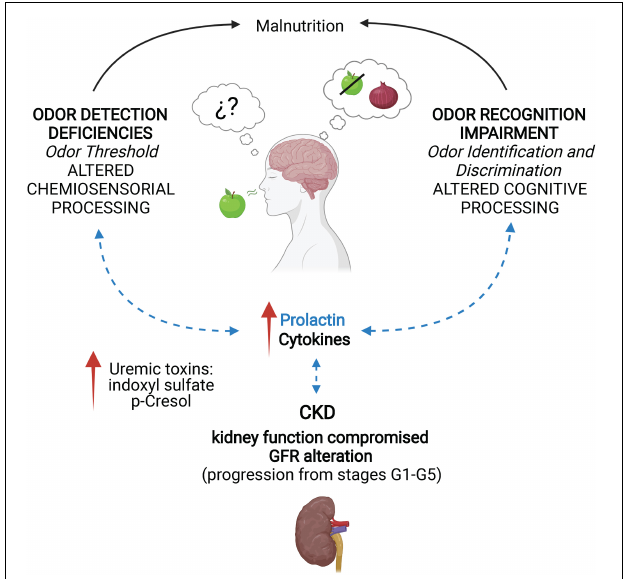
FIGURE 1 | Neuroimmune alterations and olfactory deficiencies promoted by chronic kidney disease. In chronic kidney disease (CKD), kidney function is compromised due to alterations of the glomerular filtration rate (GFR), as the disease progresses from stage G1 ( ≥ 90 ml/min/1.73 m 2 ) to G5 ( < 15 ml/min/1.73 m 2 ). This leads to increased levels of the uremic toxins indoxyl sulfate and p-Cresol. The toxin accumulation activates the immune system by releasing cytokines and increasing prolactin (PRL) levels due to inadequate GFR. CKD patients develop deficiencies in odor detection, identification, and discrimination that are reversible after renal transplantation. Additionally, olfactory alterations can cause malnutrition, worsening the patients’ condition. Evidence on the regulatory role of PRL in olfactory processing suggests an interaction between CKD-induced high PRL levels and the olfactory deficiencies (dotted blue arrows). Created with